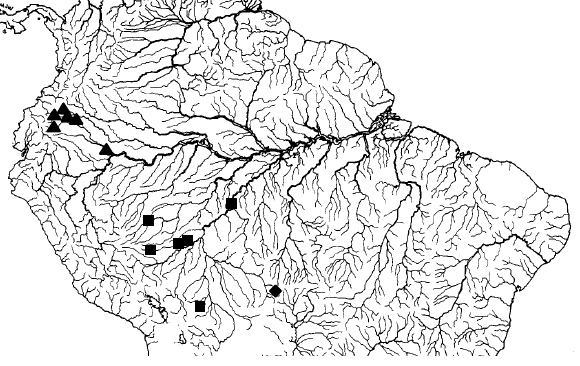
Figs. 18. Distribution of Odontostilbe ecuadorensis (tri- angles), Odontostilbe nareuda (squares), and Odontostilbe parecis (losangles). Symbols can represent more than one lot, and more than one locality.